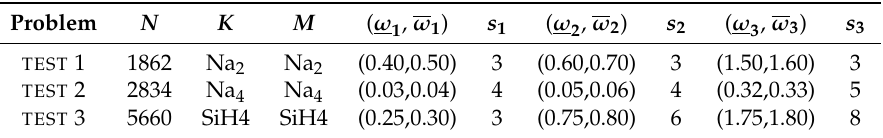
Table 2. Test matrices.